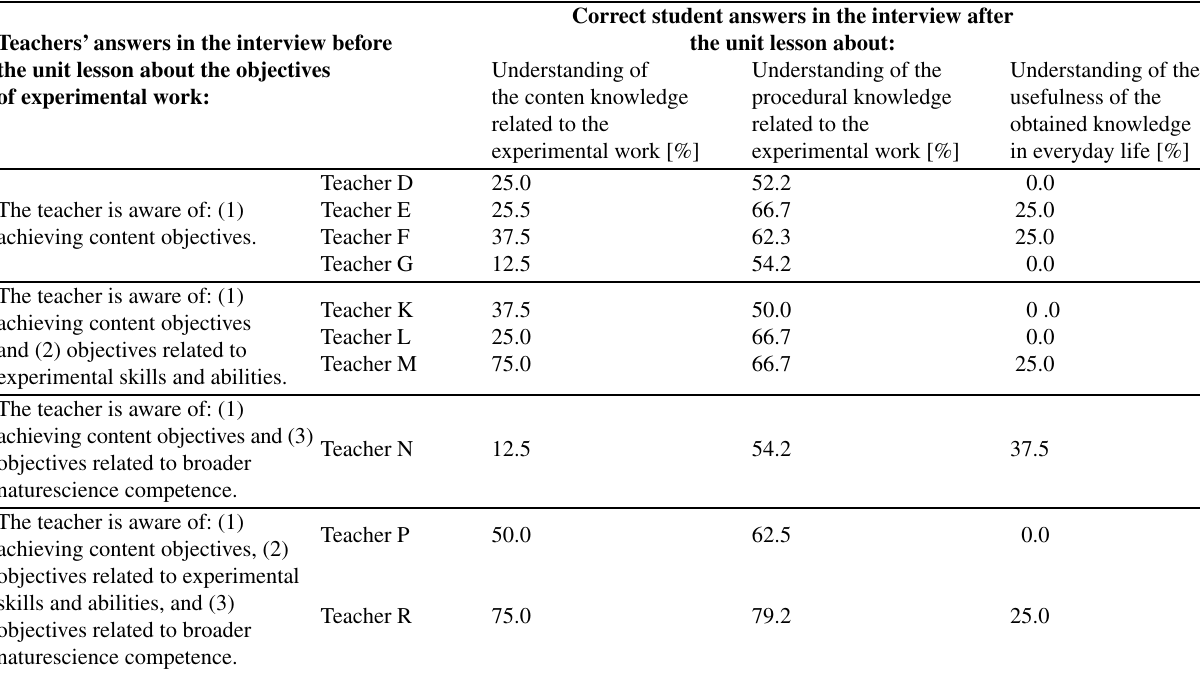
Table 5: Analysis of collected data when evaluating the knowledge of students, when the teacher is/is not aware of all the objectives of students’ hands-on experimental